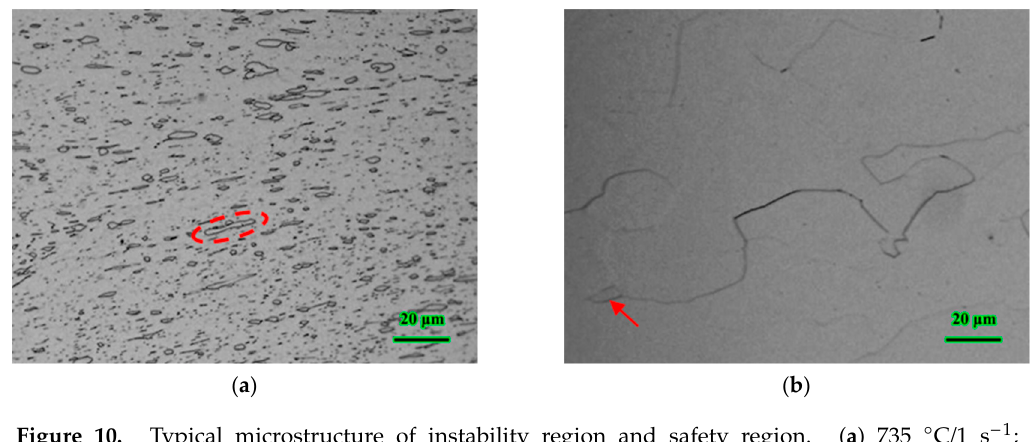
Figure 10. Typical microstructure of instability region and safety region. ( a ) 735 °C/1 s − 1 ; ( b ) 810 °C/0.001 s − 1 .